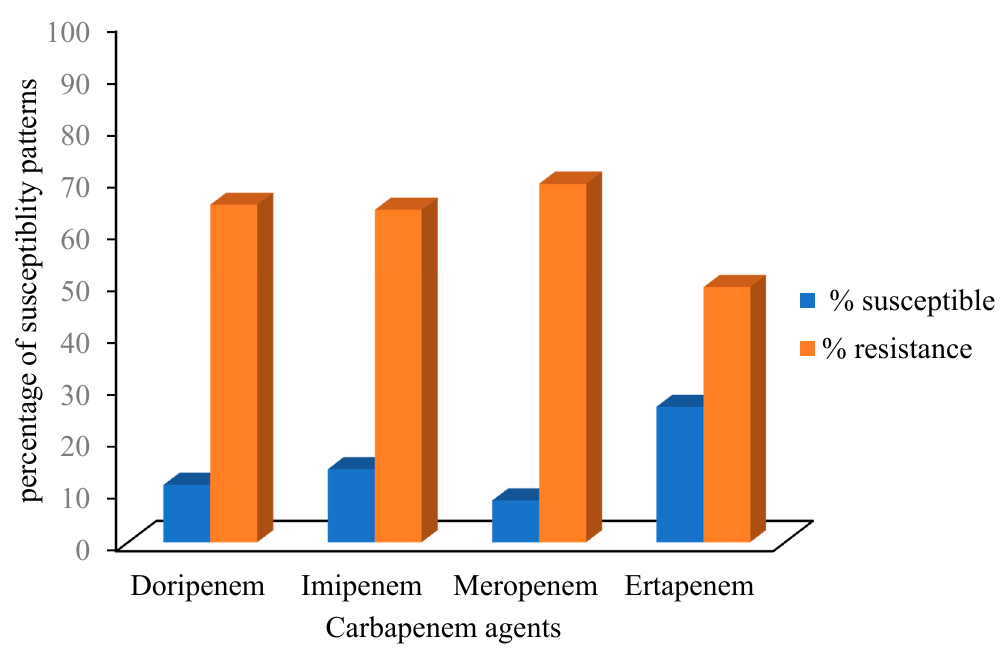
Figure 4. Antimicrobial susceptibility patterns of Klebsiella spp. isolates.